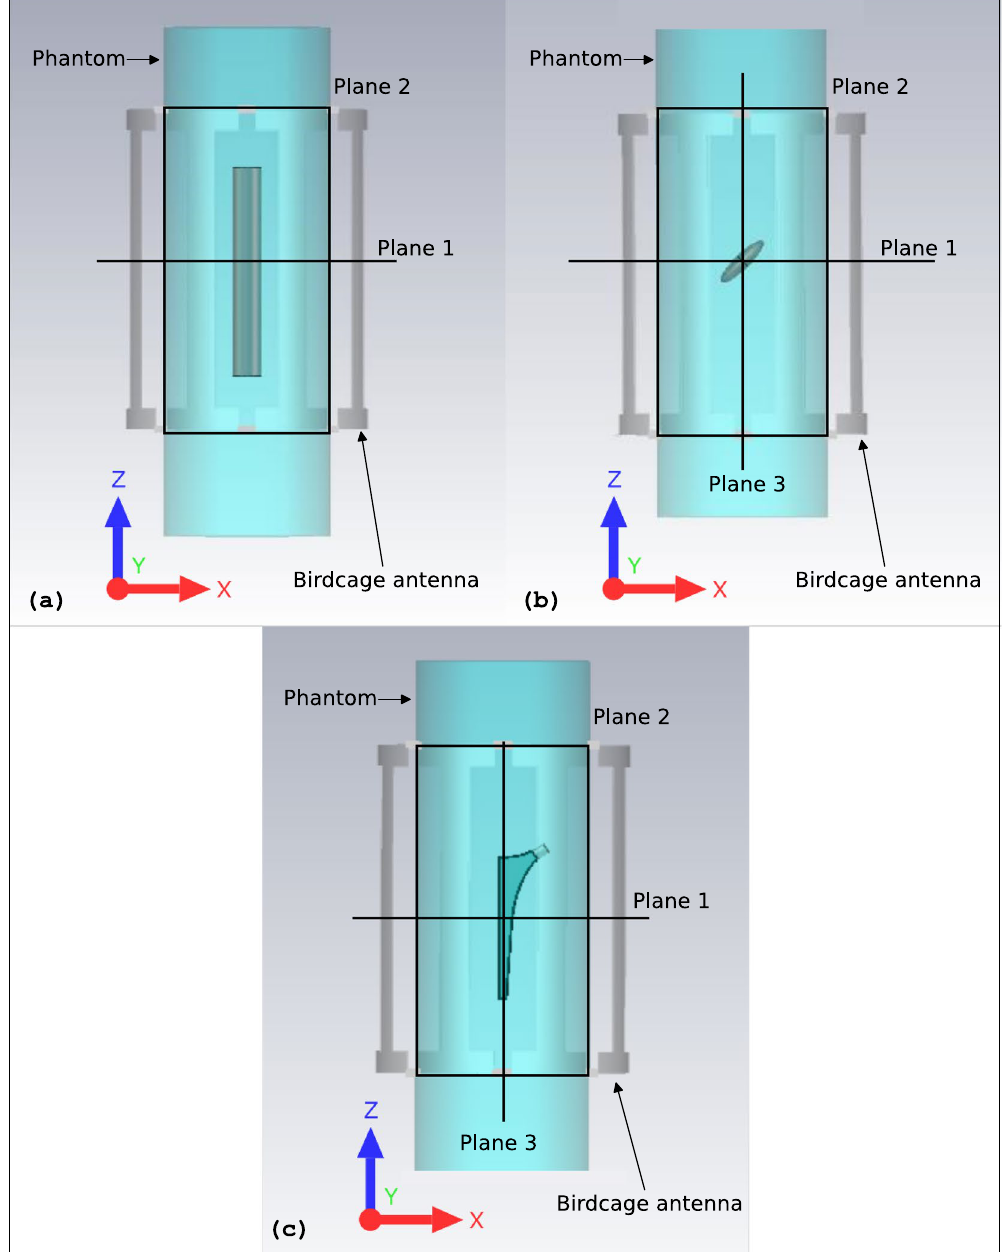
Figure 2. Simulation set-ups. Simulation set-ups relative to the PEC cylinder ( a ), PEC disc ( b ) and to the realistic model of a hip prosthesis ( c ) placed in the centre of the phantom transverse plane. The planes on which the magnetic field homogeneity and SAR were investigated are depicted. Considering the hip prosthesis model ( c ), plane 2 corresponds to the coronal plane and plane 3 to the sagittal